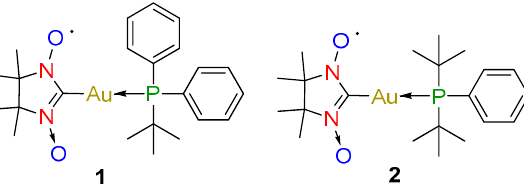
Figure 2. Newly synthesized NN-Au-P t BuPh 2 ( 1 ) and NN-Au-P t Bu 2 Ph ( 2 ).